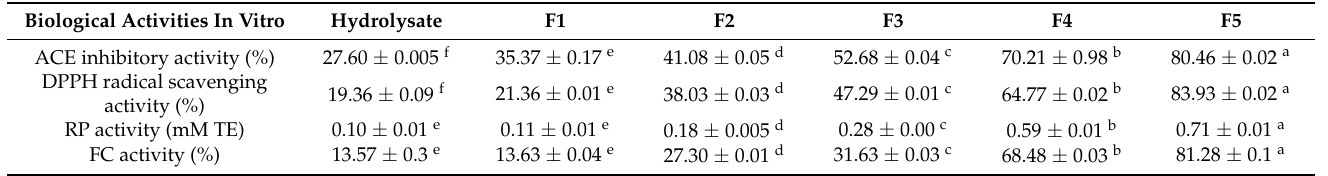
Table 3. Biological activities in vitro of full hydrolysate of giant kelp and its ultrafiltered fractions of different